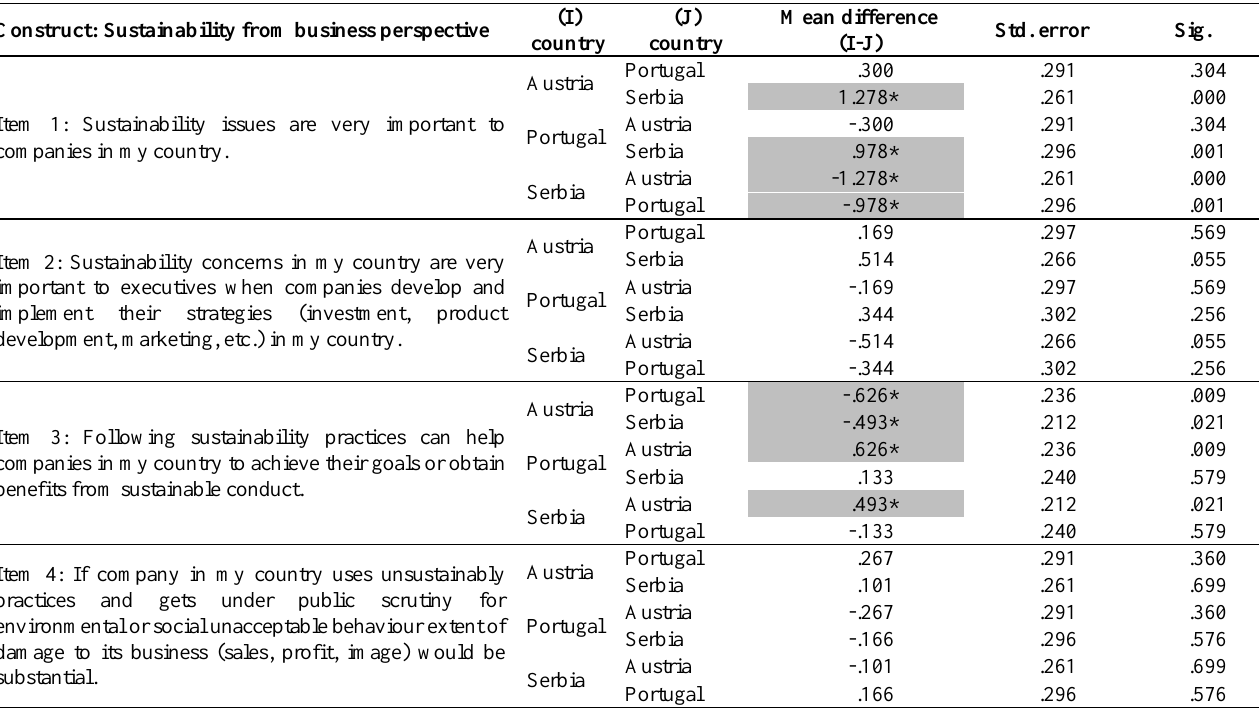
Table 5: Post-hoc test: LSD multiple comparisons “sustainability from business perspective”